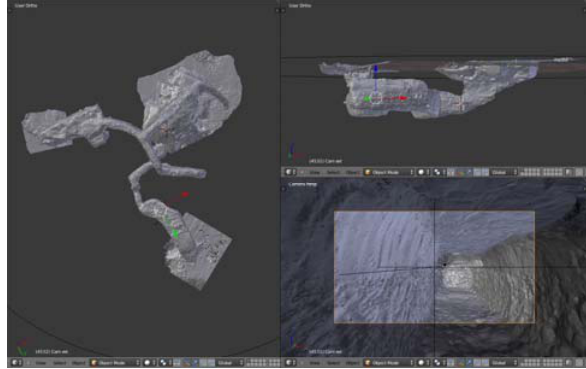
Figure 15. Production of a video inside the Marigny-Brizay medieval underground site with